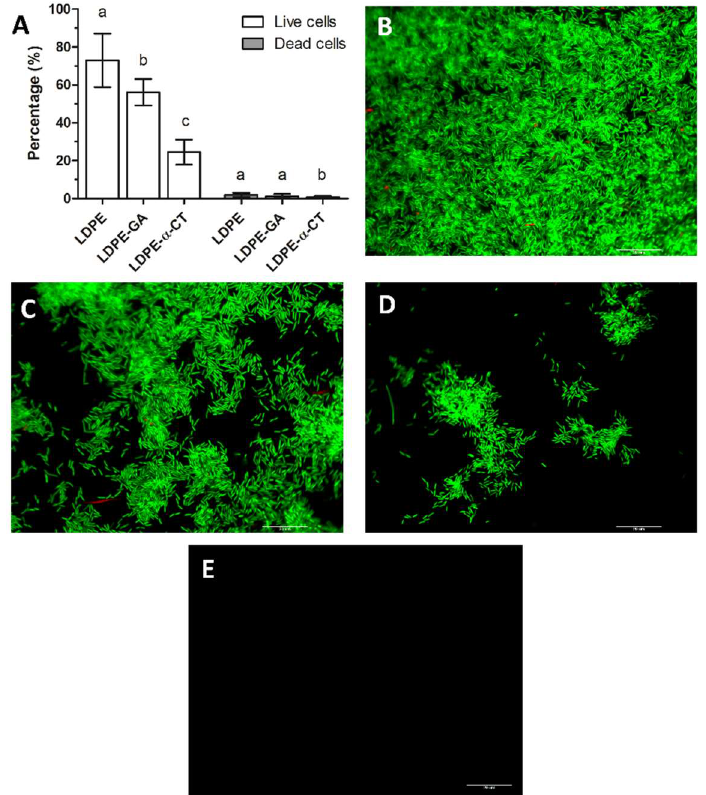
Figure 2. Epifluorescence microscope analysis. ( A ) Percentage of live and dead cells within the biofilm grown on non-functionalized (LDPE and LDPE-GA) and functionalized polyethylene surfaces (LDPE- α -CT). Data represent the mean ± standard deviation of four independent measurements. Letters a, b and c indicate significant differences (Tukey’s HSD, p ≤ 0.05) between the means of different surfaces. ( B – D ) Representative epifluorescence microscope images of E. coli biofilm stained with a Live/Dead BacLight viability kit and grown on LDPE ( B ), LDPE-GA ( C ), and LDPE- α -CT ( D ) surfaces (60 × , 1.0 NA water immersion objective). Green fluorescence corresponds to E. coli live cells ( λ ex : 480 nm and λ em : 516 nm) and red fluorescence corresponds to E. coli dead cells ( λ ex : 581 nm and λ em : 644 nm). ( E ) Representative epifluorescence microscope image of LDPE, LDPE-GA, and LDPE- α -CT without biofilm and stained with a Live/Dead BacLight viability kit showing no detectable fluorescence. Scale bar = 20 µm.